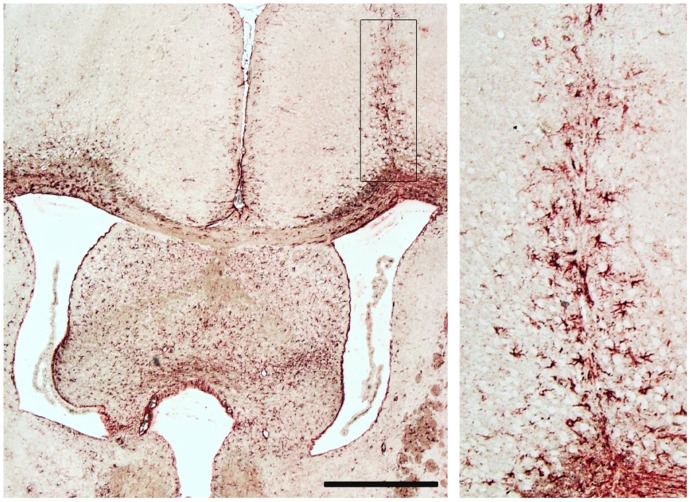
Analysis of post mortem brain tissue at day 110 of SOD1 (G93A) mice.In 5 of 12 animals there was a glial scar visible above the right ventricle as it was shown by GFAP staining. Rectangle in the left picture is showed enlarged on the right side. Scale bar 500 µm.